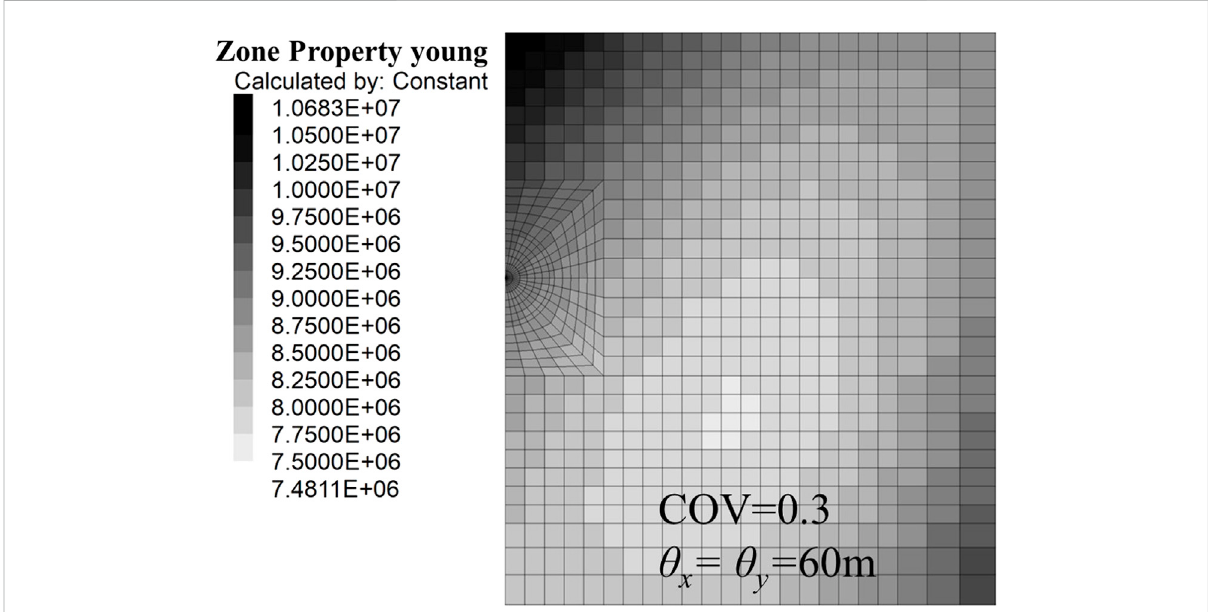
FIGURE 4 Certain realization of RFM based on isotropic random fi eld.